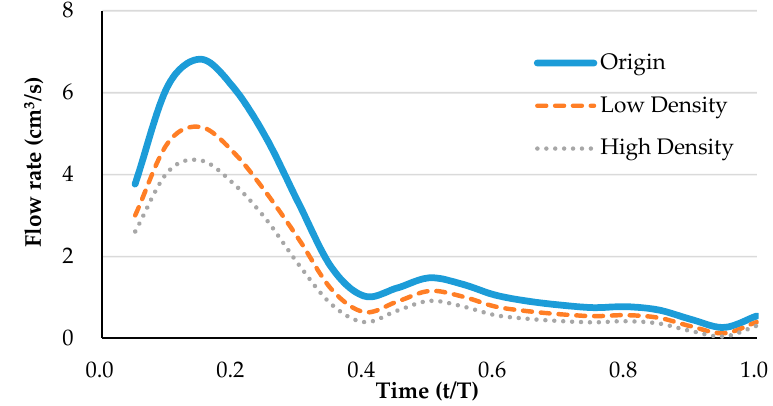
Figure 8. Reduction of blood flow by occlusion device in single pulse at outlet 2.